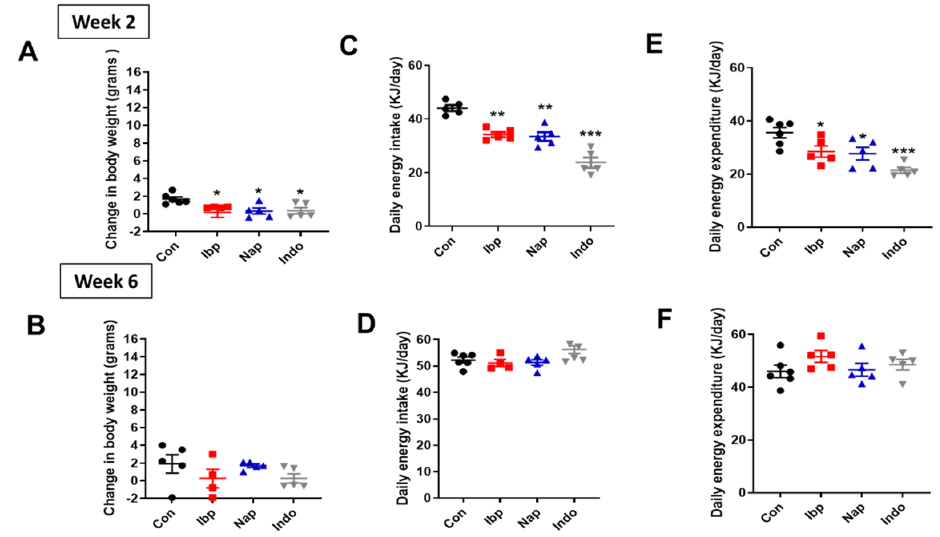
Figure 2. Intragastric administration of variable NSAIDs causes a transient reduction in body weight and alteration in energy balance in normal chow-fed mice. ( A , B ) Change in body weight (grams), ( C , D ) Average daily energy intake (KJ/day) and ( E , F ) daily energy expenditure (KJ/day) during week 2 and week 6 post-intragastric gavage of PBS/control (Con), ibuprofen (Ibp), naproxen, (Nap), or indomethacin (Indo) in C57 Blc/6J male mice that were placed on a normal chow diet (ND). All results are presented as mean ± SEM (error bars). One-way ANOVA was used to compared means of each NSAID group to the control group. ANCOVA correction for body weight was applied for total daily energy expenditure. Statistical significances are denoted with asterisks as follows: *, p ≤ 0.05; **, p ≤ 0.01; ***, p ≤ 0.001.